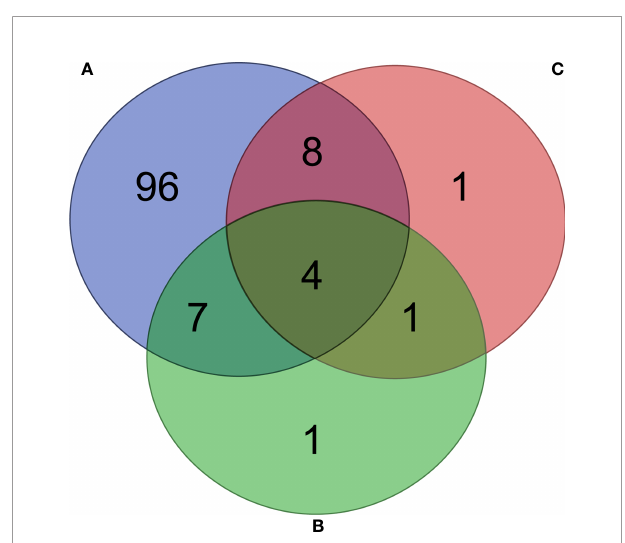
FIGURE 9 | Comparison of unique and share pathways across the different groups. Venn diagram showing the common and different predicted bacterial pathways found in the microbiome of ticks fed on mock-immunized mice compared to unfed ticks (A) , and ticks fed on L. mesenteroides -immunized (B) and E. coli -immunized (C) mice compared to mock-immunized mice. Only pathways with statistically signi fi cant log2 fold changes in the absolute value (cutoff of 1) were Table S6 ). A signi fi cant decrease in the relative abundance of the L-lysine fermentation to acetate and butanoate pathway (P163-